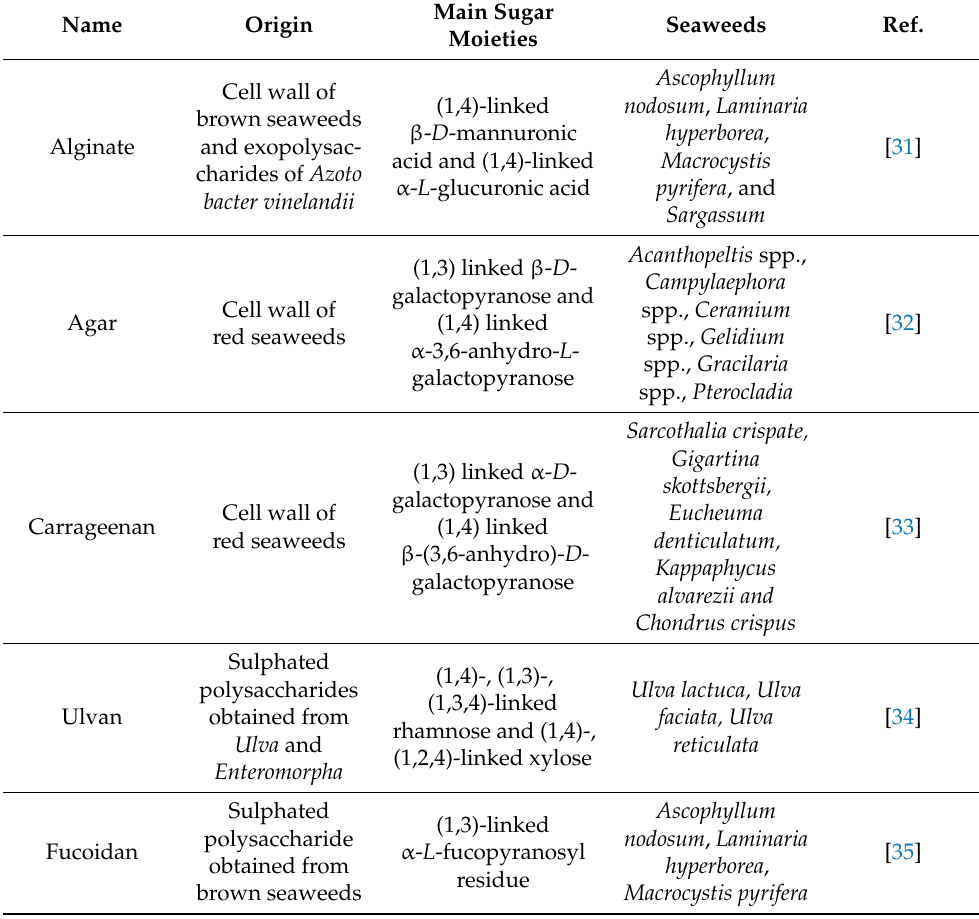
Table 1. Origin of commercially important seaweed